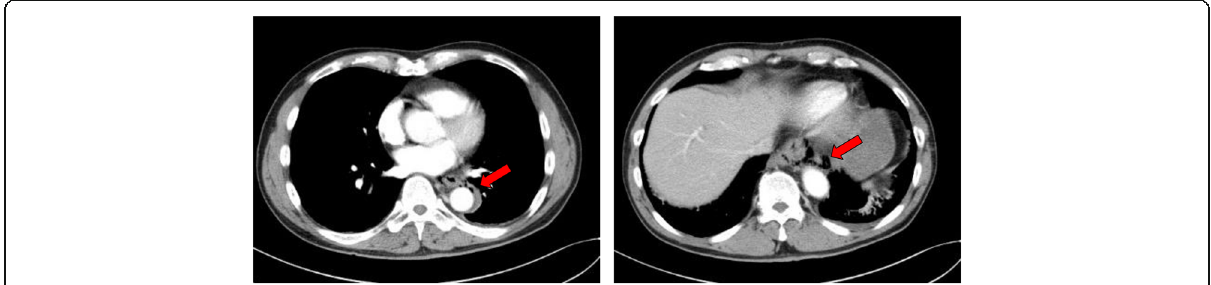
Fig. 1 Computed tomography (CT) scan. CT revealed pneumomediastinum extending from the upper surface of the diaphragm to the aortic